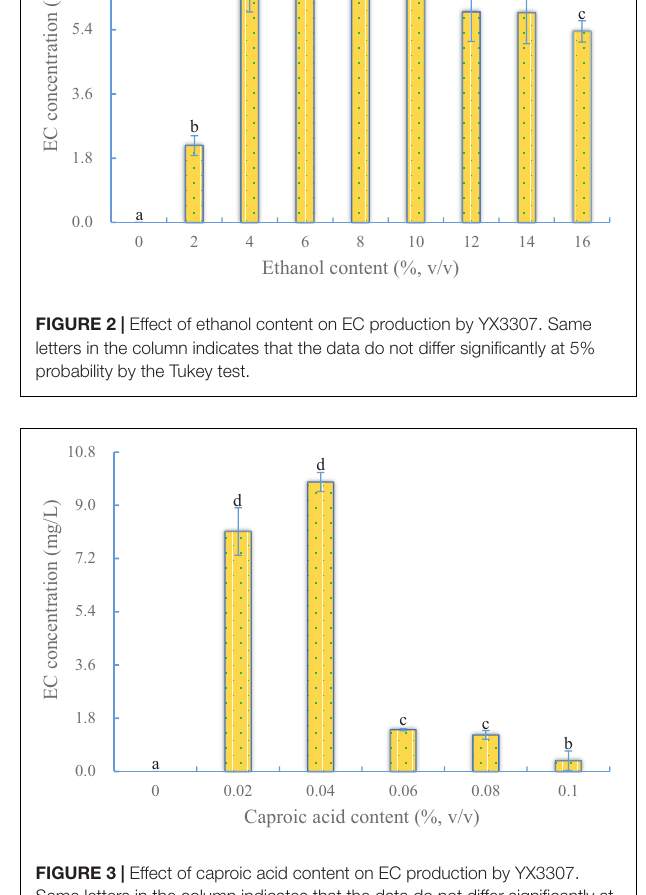
FIGURE 3 | Effect of caproic acid content on EC production by YX3307. Same letters in the column indicates that the data do not differ significantly at 5% probability by the Tukey